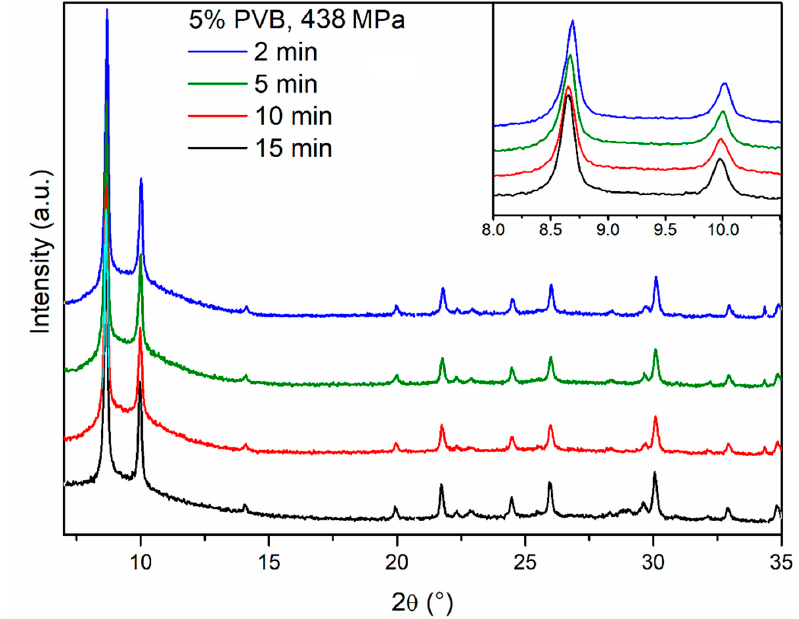
Figure 8. PXRD patterns of pellets prepared compressing MOF-801 blended with 5% PVB under 438 MPa of pressure for 15 min (black), 10 min (red), 5 min (olive) and 2 min (blue). The inset shows the low angle region.